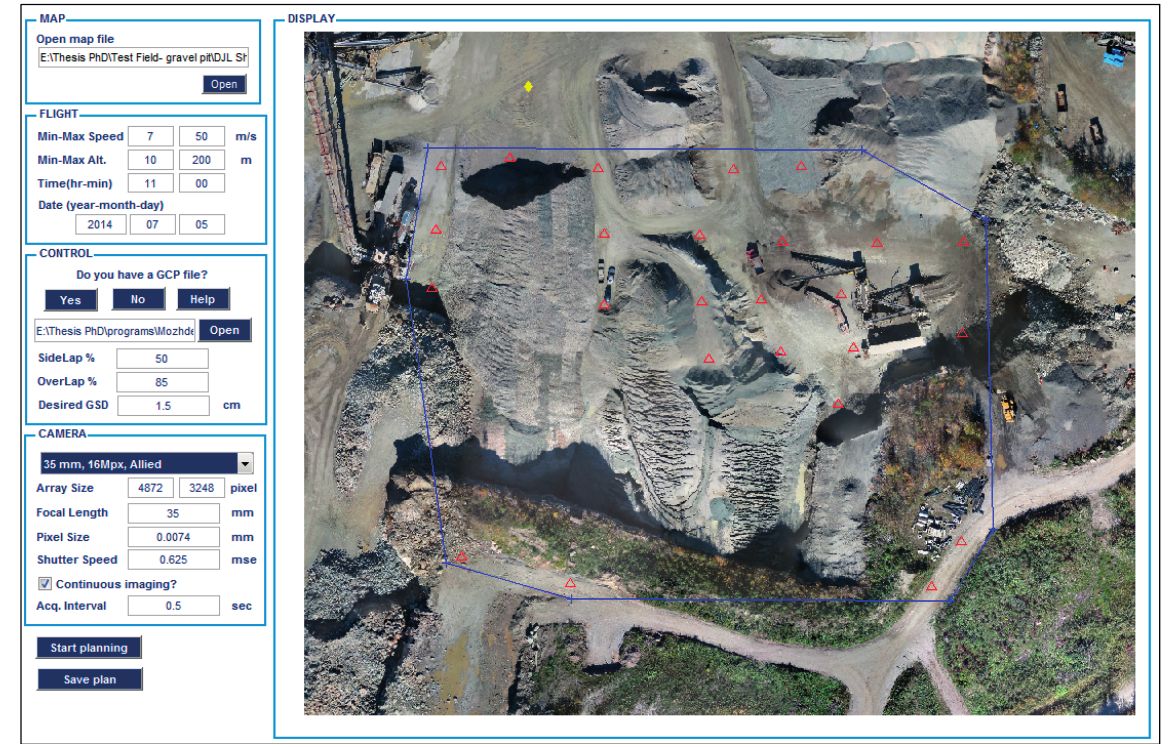
Figure 6. Interface of the flight-planning software.